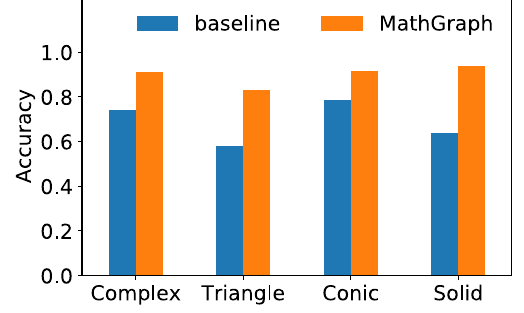
Fig. 7 Overall accuracy on four datasets